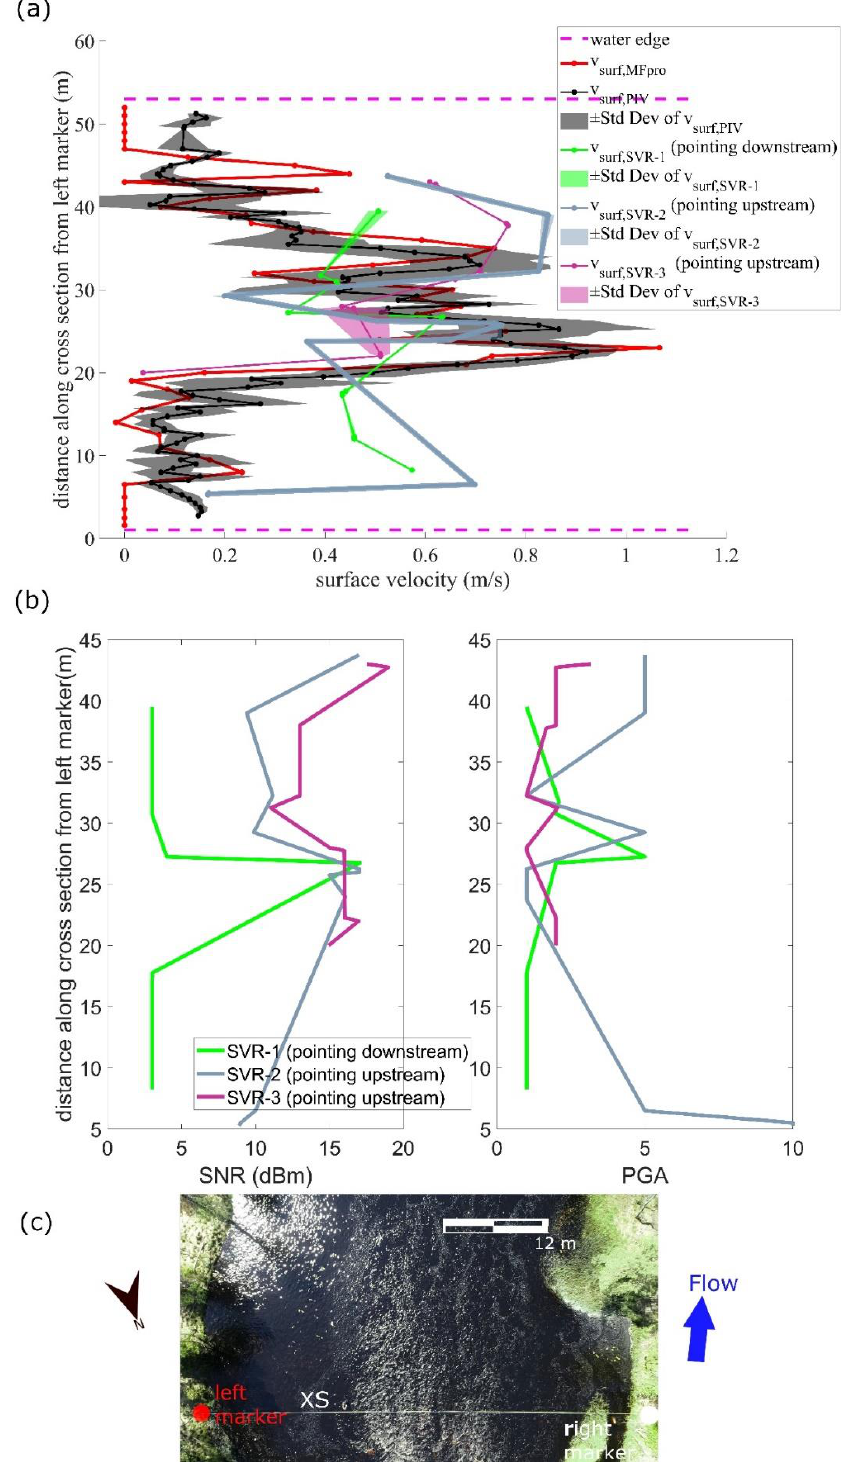
Figure 8. Krokån XS (SE). ( a ) surface velocity comparing: MFpro measurements of surface velocity (v surf,MFpro ), UAS-borne PIV measurements (v surf,PIV ) and three UAS-borne SVR (v surf,SVR-1 pointing downstream, v surf,SVR-2 and v surf,SVR-3 pointing upstream) surveys. ( b ) Comparison of two quality indicators (SNR and PGA) for the SVR surveys. SVR and PIV are represented with shaded regions to present standard deviation ( ± Std Dev). ( c ) UAS-borne video frame of the XS (North arrow, approximate flow direction and approximate scale are also